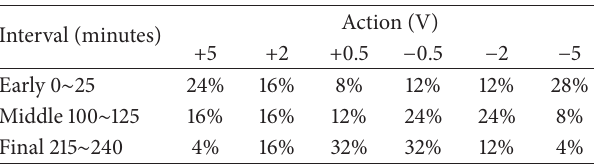
Table 3: The percentage of choosing action in different phase for the experiment with real weather